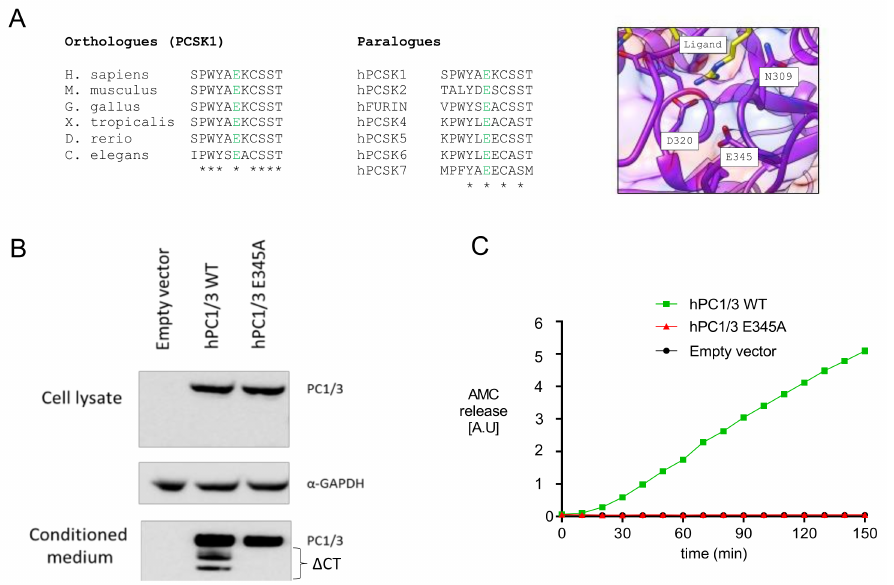
Figure 2. PC1/3-p.E345A has autocatalytic activity but is unable to cleave substrates in trans. ( A ) Alignment of E345 between different species and the other members of the PC family, and visual representation of the of the E345 residue in the 3D structure of PC1/3. ( B ) Maturation and secretion of PC1/3-WT and PC1/3-p.E345A. Western blot of transiently transfected PC1/3-WT and PC1/3-p.E345A in HEK239T cells. GAPDH was used as housekeeping gene. ∆ CT: C-terminally truncated PC1/3. ( C ) Enzymatic activity of secreted PC1/3-WT and PC1/3-pE345A was compared using Suc-Leu-Leu-Val-Tyr-AMC as substrate. hPC1/3: human PC1/3; WT: wild-type; AMC: 7- amino-4-methylcoumarin